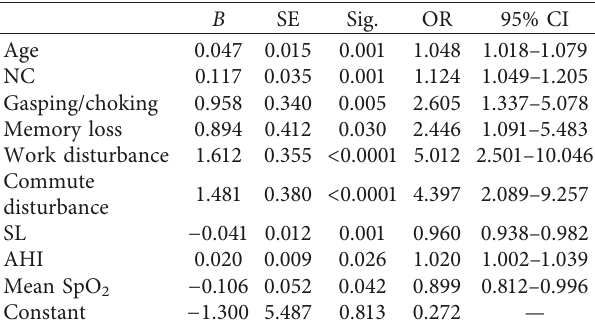
Table 5: Multivariate analysis of severe EDS by binary logistic